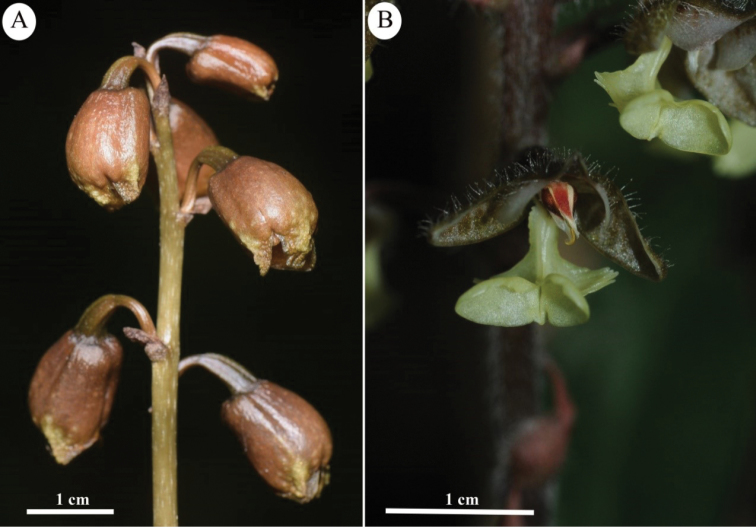
New species discovered from Myanmar AGastrodia
kachinensis X.H.Jin & L.A.Ye. BOdontochilus
putaoensis X.H.Jin, L.A.Ye & A.T.Mu. Photos by X.H. Jin.